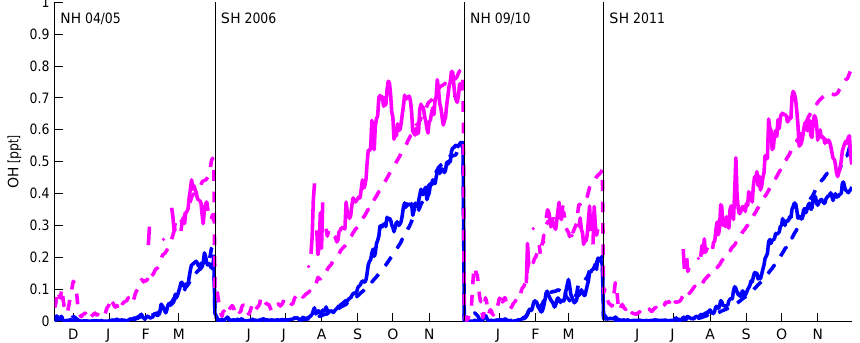
Figure 4. Vortex-averaged mixing ratio of OH for the Arctic winter 2004/2005, the Antarctic winter 2006, the Arctic winter 2009/2010 and the Antarctic winter 2011 at 54hPa. Vortex average (solid blue) and parameterization for the mixing ratio by FAS 2 (dashed blue) and average over sunlit part of vortex (solid magenta) and parameterization for the mixing ratio by FAS (dashed magenta). Tick marks on the horizontal axis show start of